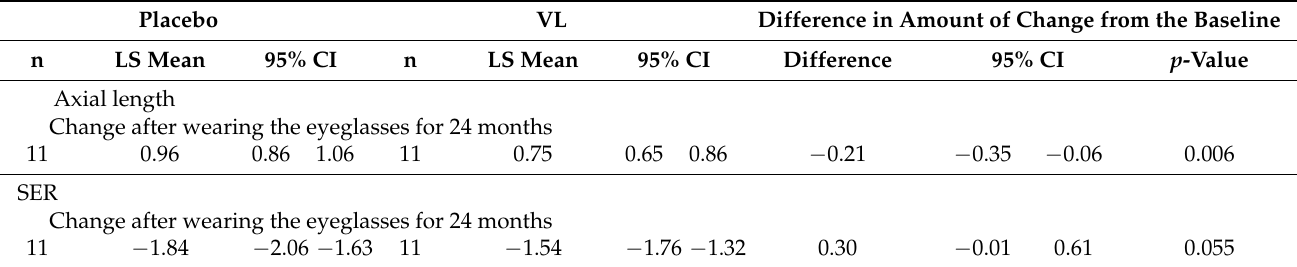
Table 5. Results of the mixed-effects model fitted to 24 months of change for both eyes under the limited condition in which near-work time is less than 180 min and there was no previous history of eyeglasses use. Placebo Axial length Change after wearing the eyeglasses for 24